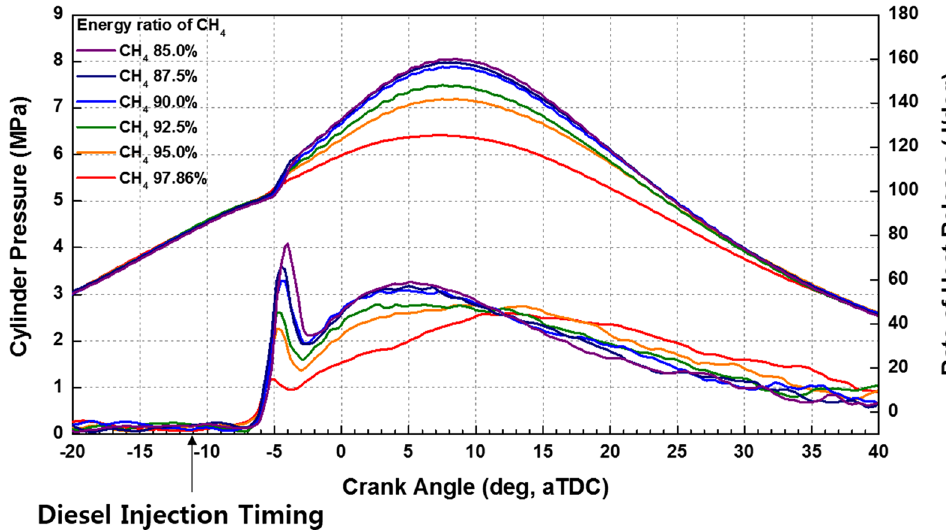
Figure 12. Cylinder pressure and ROHR with respect to the fuel mixture ratio in the optical engine.